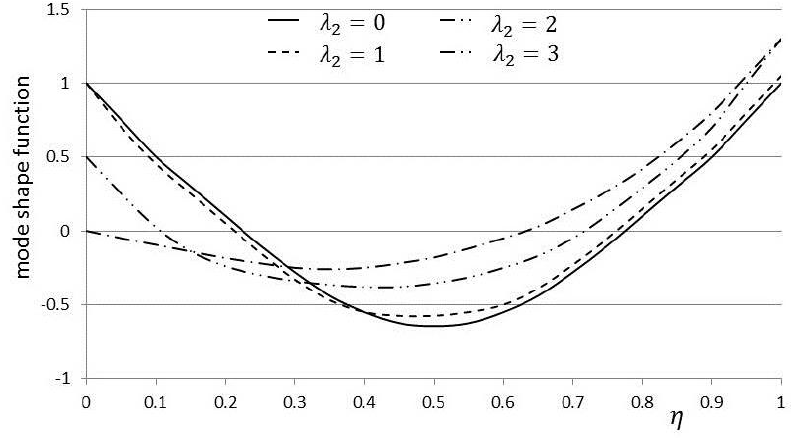
Figure 5. Effect of thrust magnitude on the first mode shape function, for 𝛽 = 0.5.